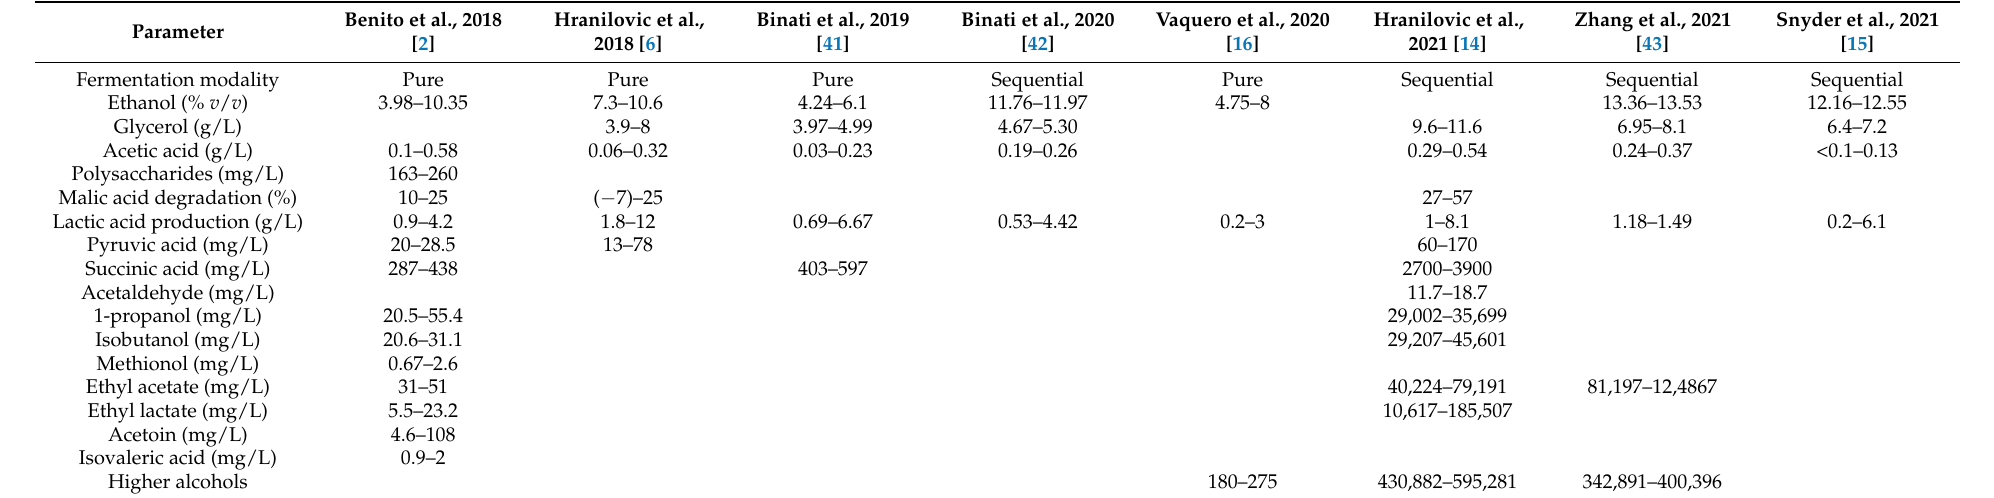
Table 1. Summary of the variability reported for L. thermotolerans for several wine fermentation quality